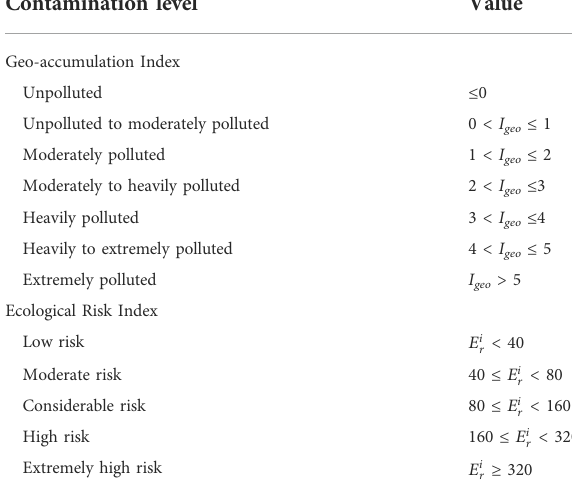
TABLE 1 The Geo-accumulation Index ( I geo ) and Ecological Risk Index ( E r i ) have the same link between contamination level and